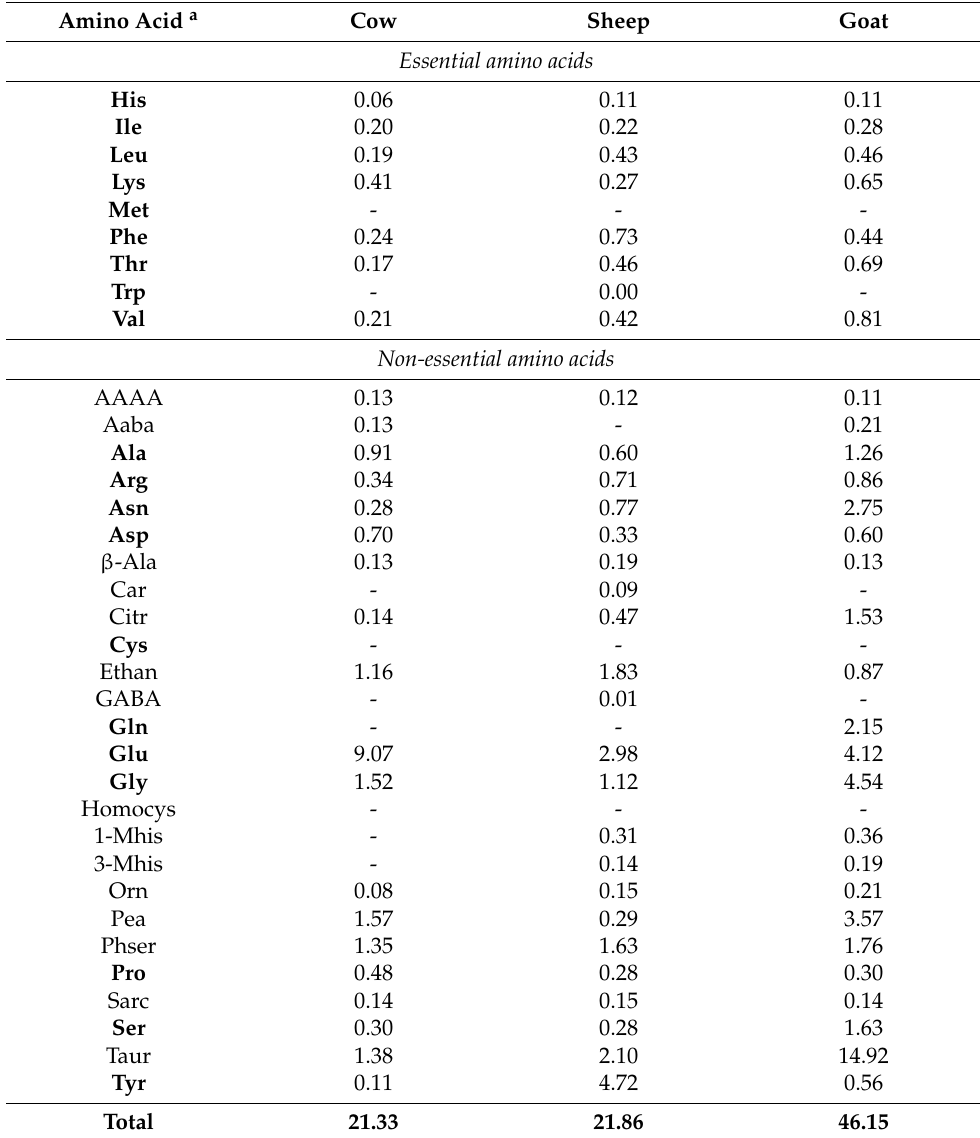
Table 8. Free amino acid composition of ‘Alto Casertano’ milk samples. Values are means from ‘Ailano’ and ‘Valle Agricola’ milk and are expressed as mg per 100 g of milk. Free Amino Acid Composition of ‘Alto Casertano’ Milk Amino Acid a Cow Sheep Goat Essential amino acids